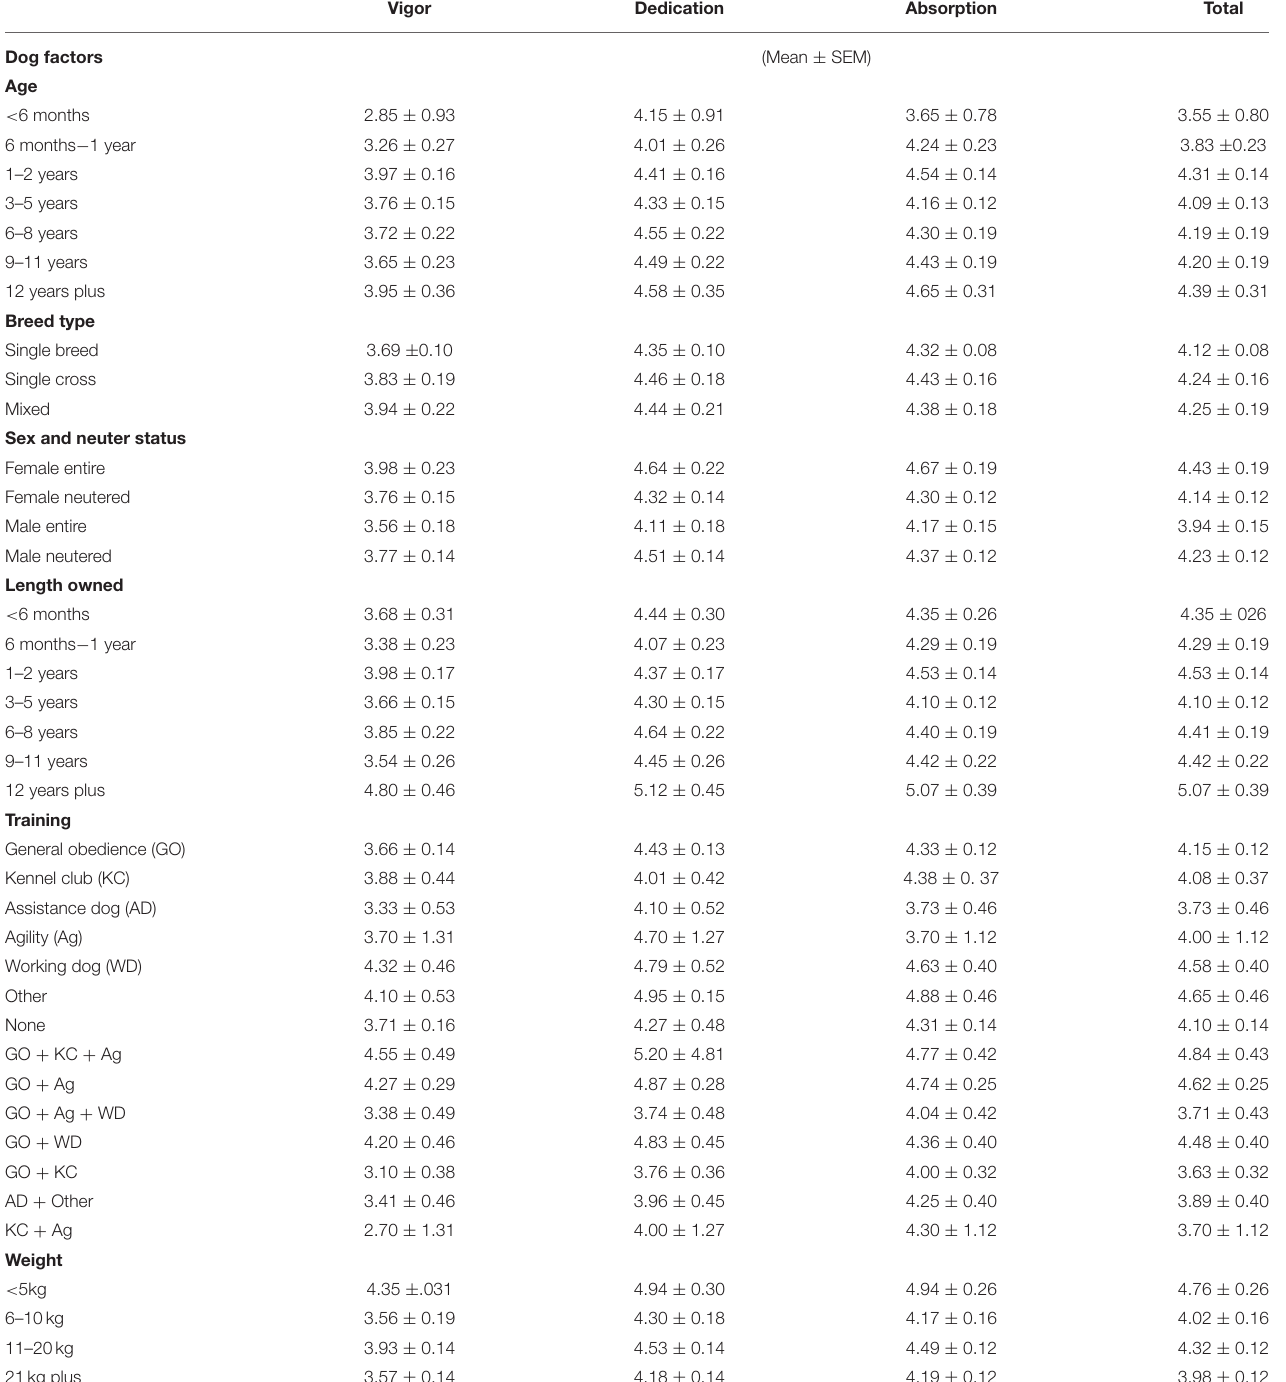
TABLE 3 | Descriptive statistics for work engagement in employees who take their dog to their office as a function of dog-based demographics.